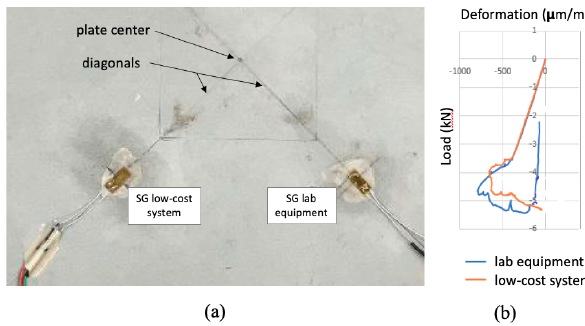
Figure 7: Results of the five-point bending test for the FR concrete plate: symmetric placement of strain gauges (a); comparison of load-vs-deformation plots (b). Measurements carried out with laboratory equipment, in blue (dark grey), and with the proposed low-cost device, in orange (light